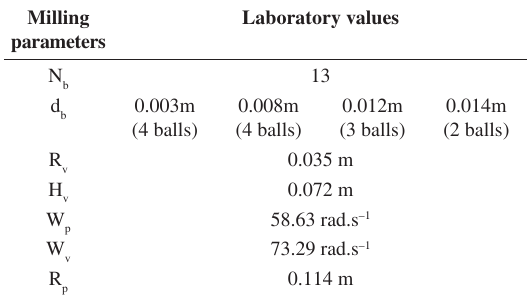
Table 4. Milling parameters non-optimized values in planetary mill.